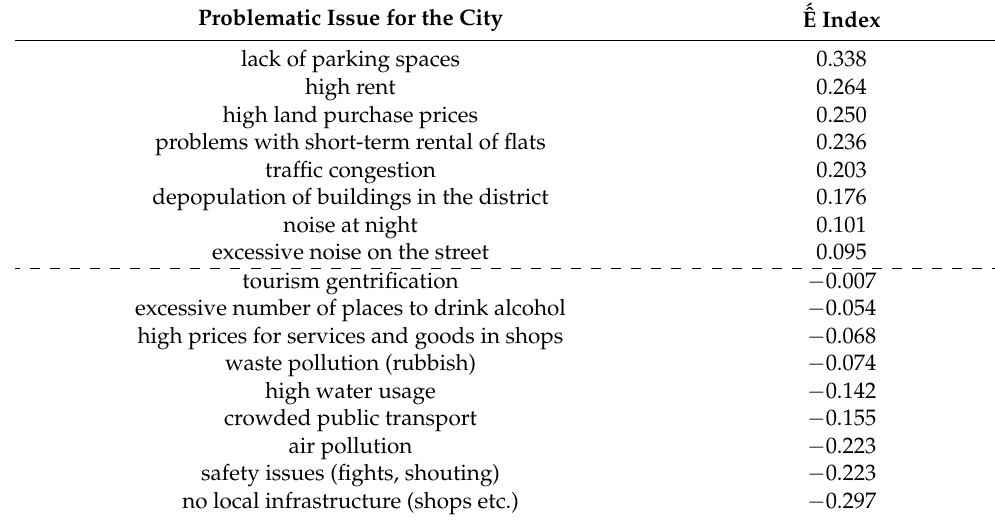
Table 2. Problematic Issue for the City.